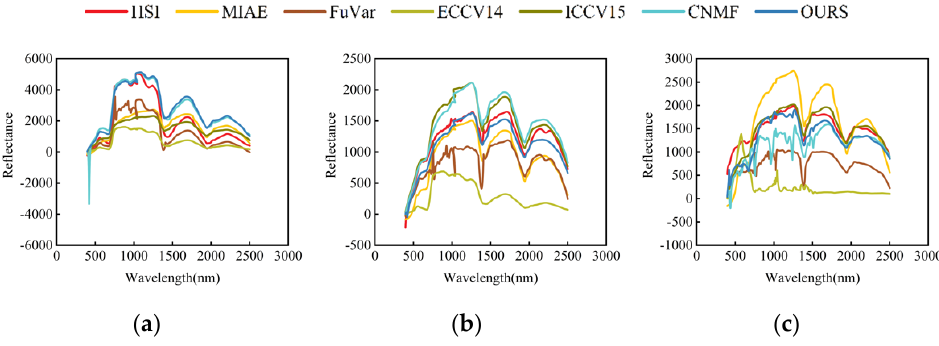
Figure 6. Different spectral lines of SRR results on ZY − 1 02D HSI. ( a ) vegetation; ( b ) soil; and ( c ) blue-roofed building. ( c ) blue-roofed